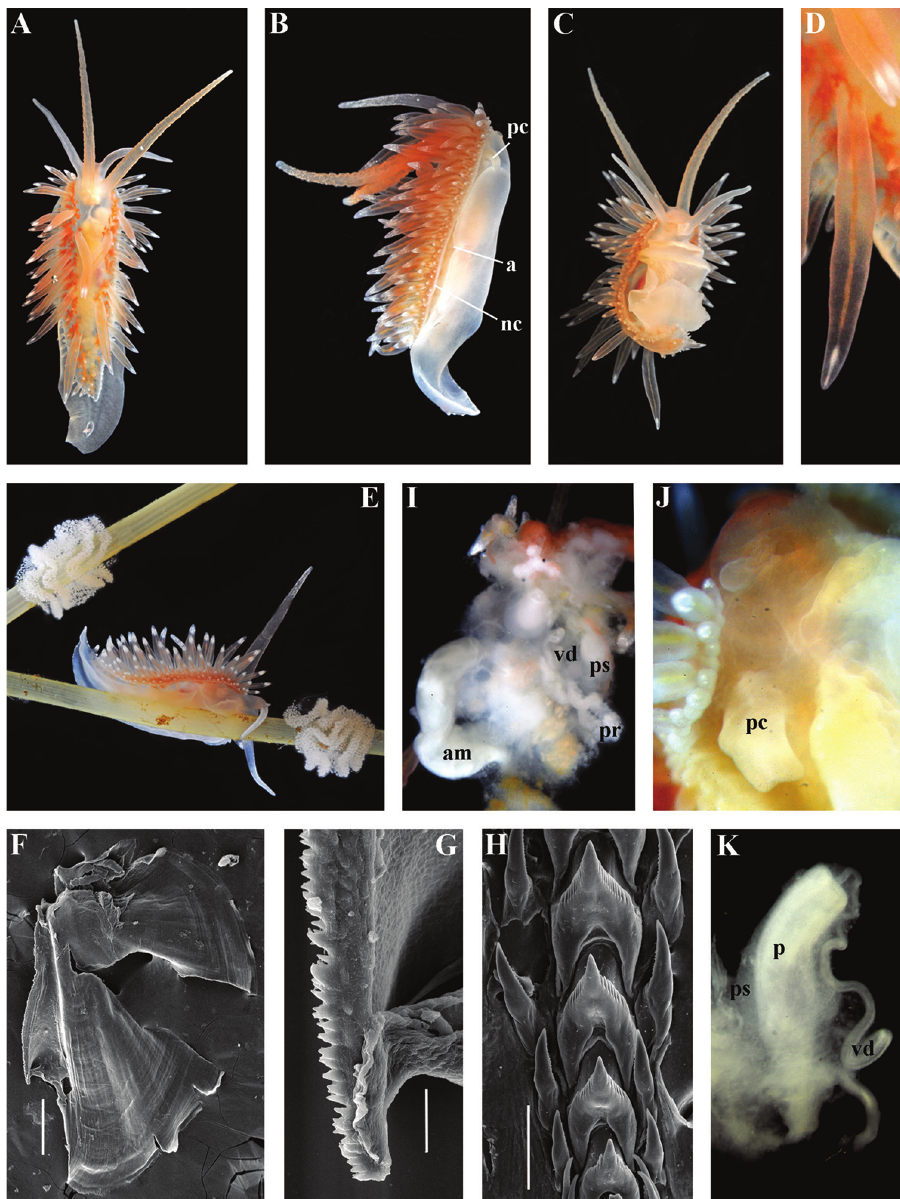
Figure 5. Chlamylla intermedia (Bergh, 1899). ZMMU Op-480. White Sea, Cape Kartesh, living animal 23 mm in length: A dorsal view B lateral view C ventral view D details of cerata E living animal and its egg masses on a Tubularia stem F jaw, SEM G details of masticatory process of jaw, SEM H radular teeth, posterior part, SEM I reproductive system J details of external penial collar K details of penis inside of penial sheath. Abbreviations: a anus am ampulla nc continuous notal edge p penis pc penial collar (ex- ternal) pr prostate ps penial sheath vd vas deferens (muscular part). Scale bars: F = 300 μm; G = 30 μm; H = 100 μm. Photos and SEM images by T.A. Korshunova, A.V.